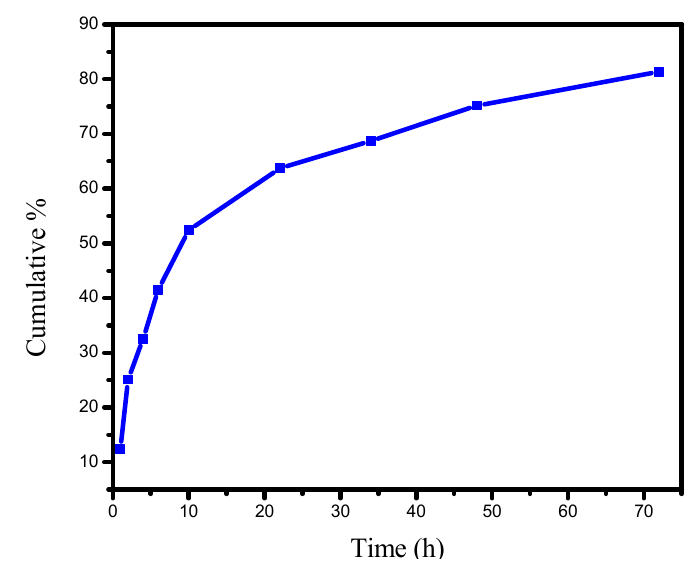
Figure 10. The release profiles of PANV-CS/TPP prepared using a 5.0:1 CS/TPP mass ratio.